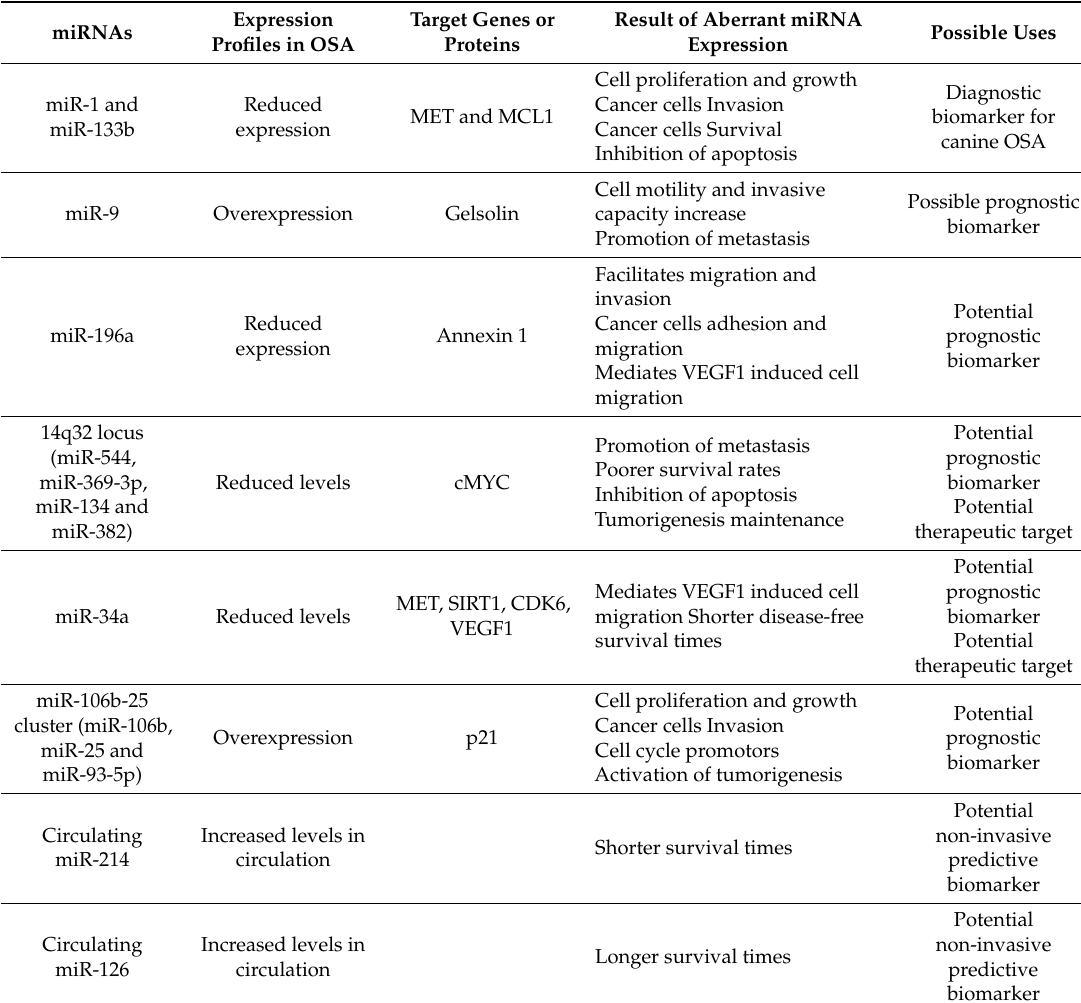
Table1. miRNAsrelatedtoOSA,targetofthesemiRNAs,